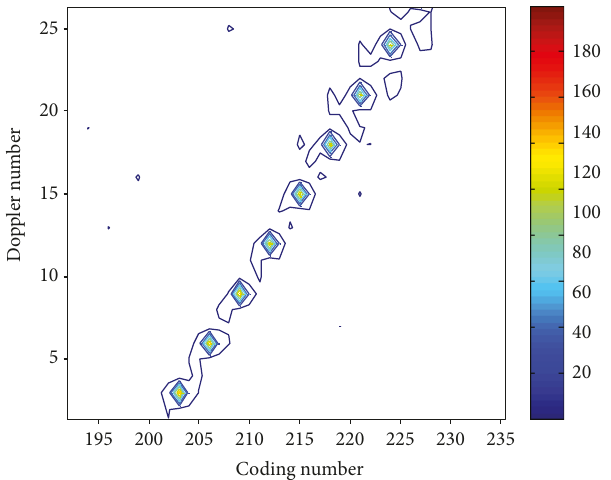
Figure 6: Contour map of the ambiguity fi gure.